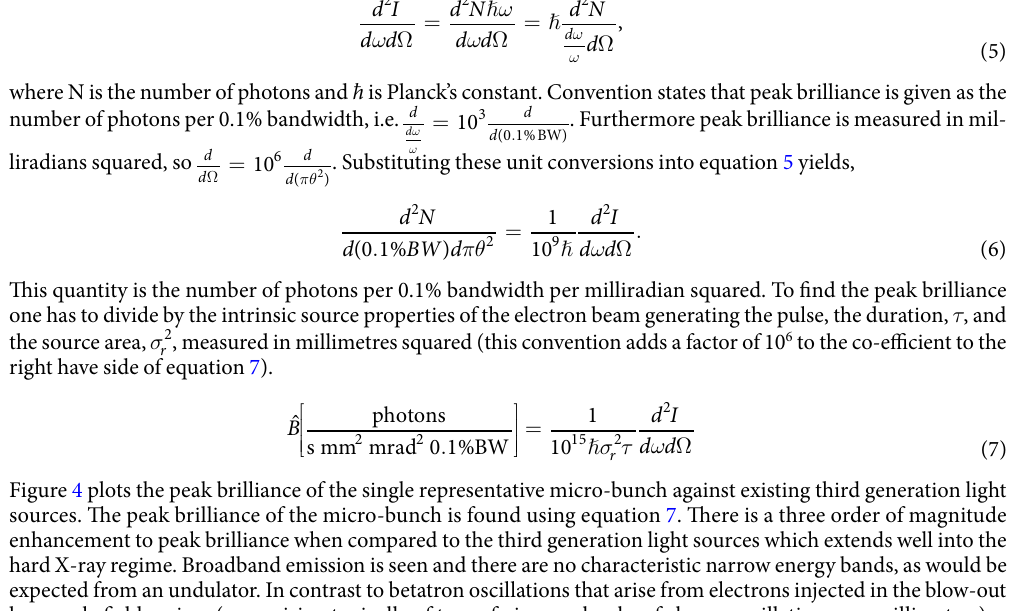
where N is the number of photons and ħ is Planck’s constant. Convention states that peak brilliance is given as the number of photons per 0.1% bandwidth, i.e.